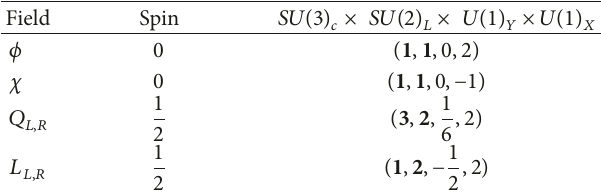
Table 2: New scalars and fermions in the model of